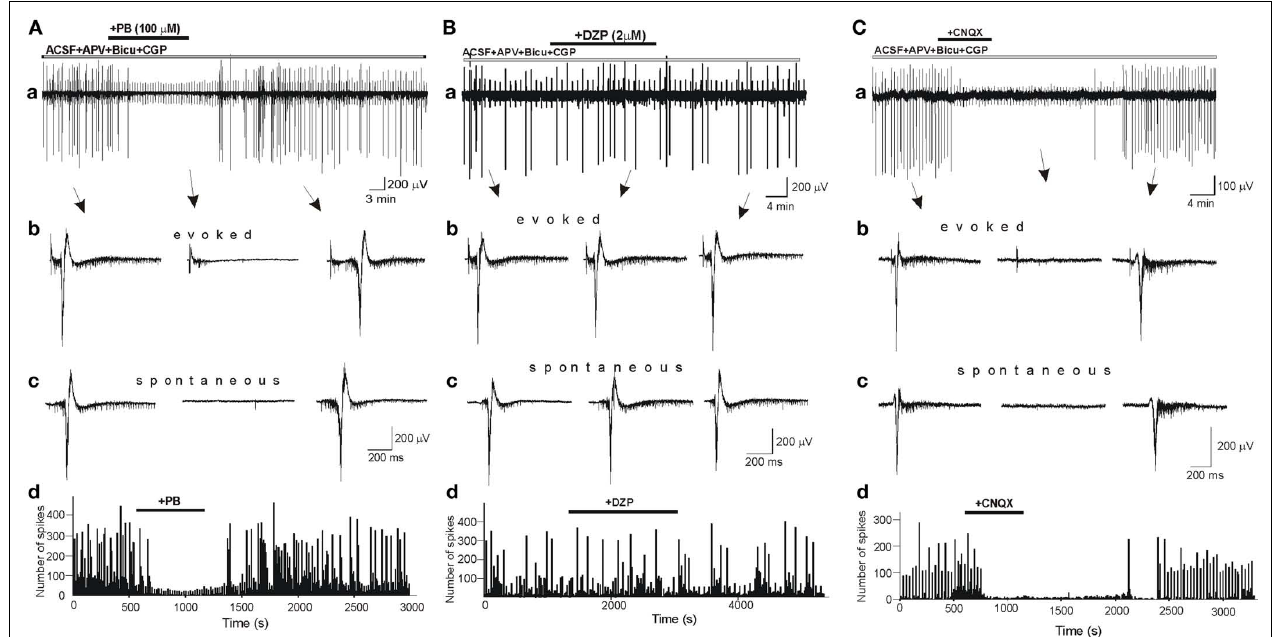
Non-filtered faster display traces of evoked (Ab,Bb,Cb) and spontaneous (Ac,Bc,Cc) IILEs. Generation of IILEs in these conditions is mediated by AMPA/kainate receptors as they were reversibly blocked by CNQX (C) . Note that PB but not DZP completely blocked IILEs and reduced the frequency of spikes (Ad,Bd) .